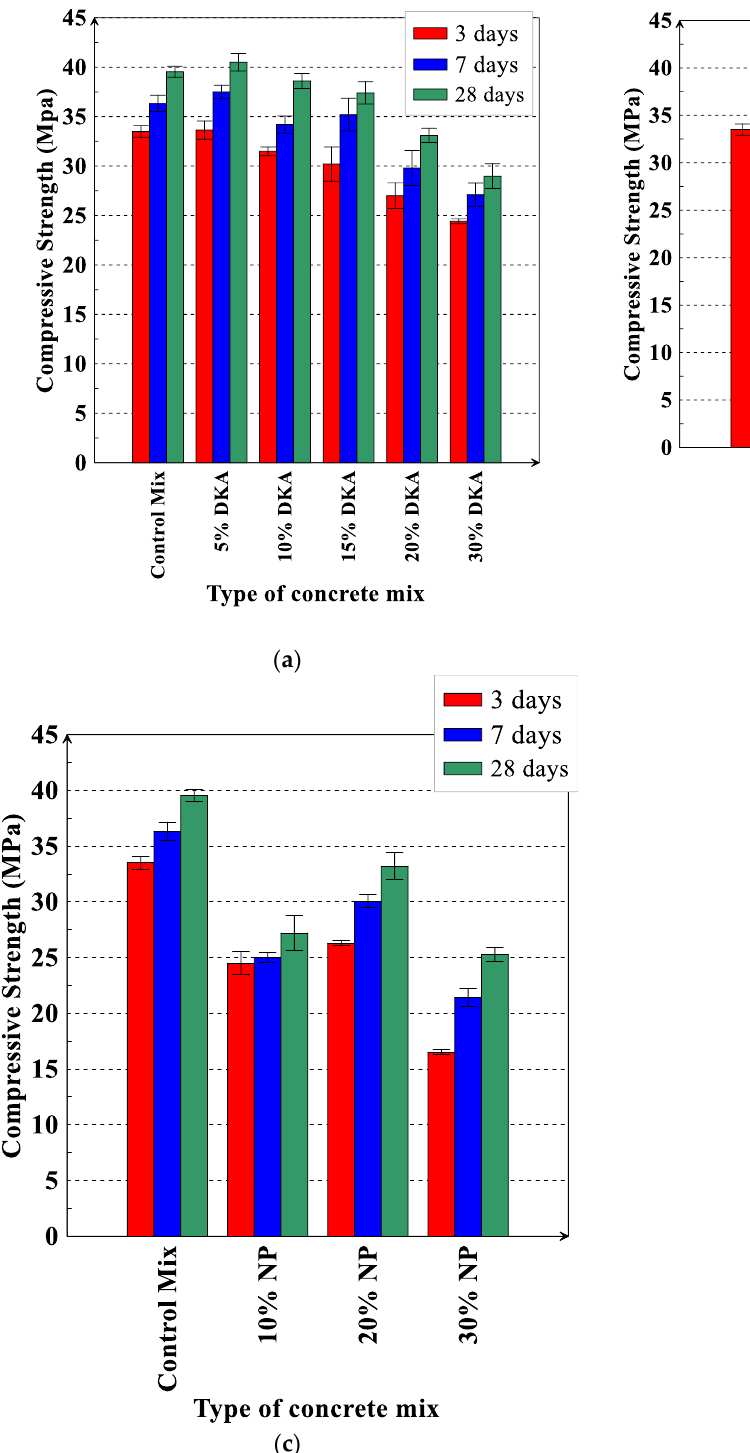
Figure 22. Compressive strength of concrete mixtures for ( a ) DKA, ( b ) FA, and ( c ) NP. Error bars represent one standard deviation from the average of three